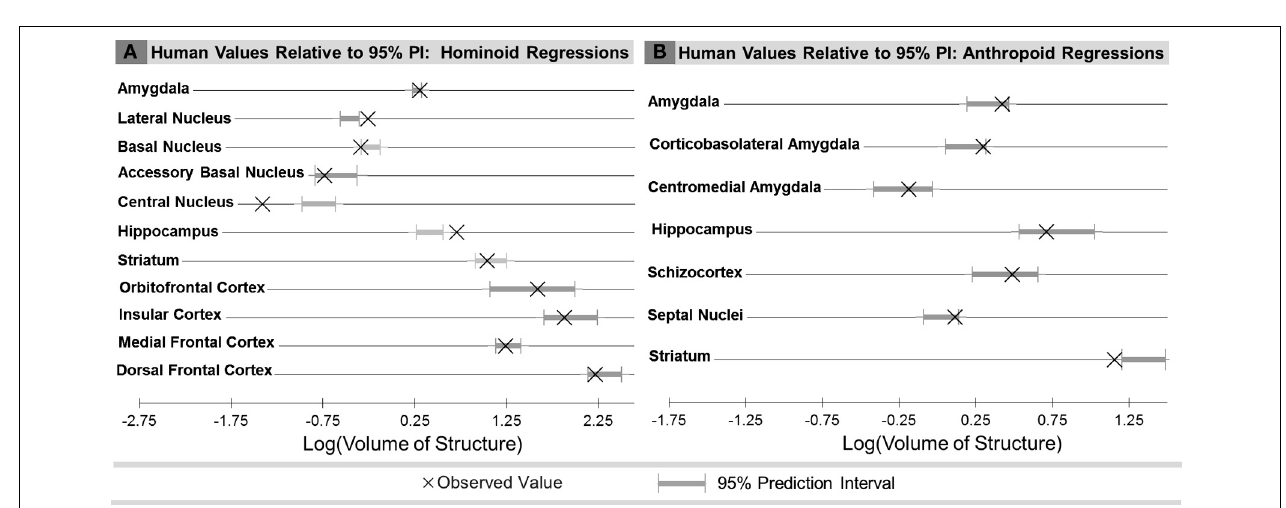
residuals that were significant, determined either by 95% prediction intervals (subcortical structures) or comparison of means at p < 0 . 05 (cortical